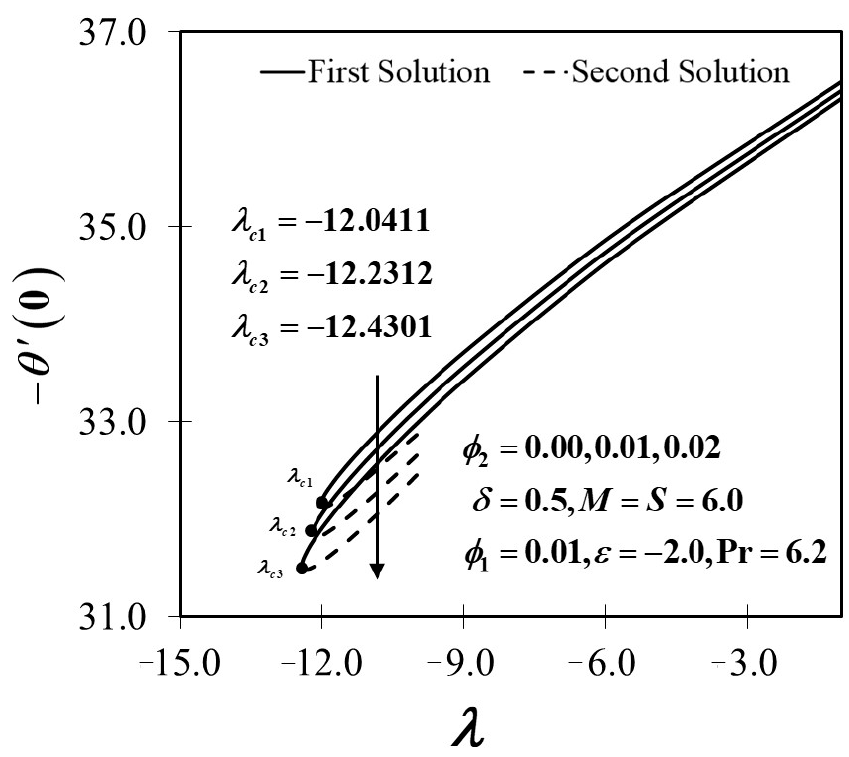
( ) (cid:48) ( 0 ) against λ by various φ 0 θ ′− against λ by various ( ) 0 θ ′− against λ by various